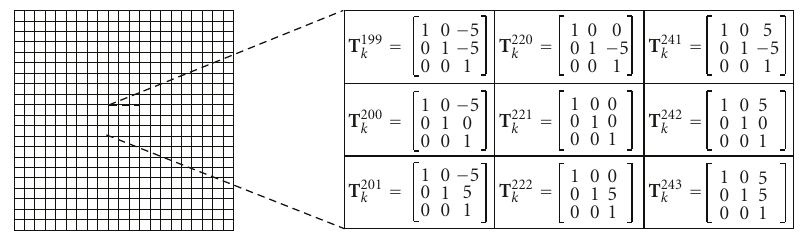
Figure 6: Initial set of a ffi ne transformation samples used to roughly approximate p ( g k ).